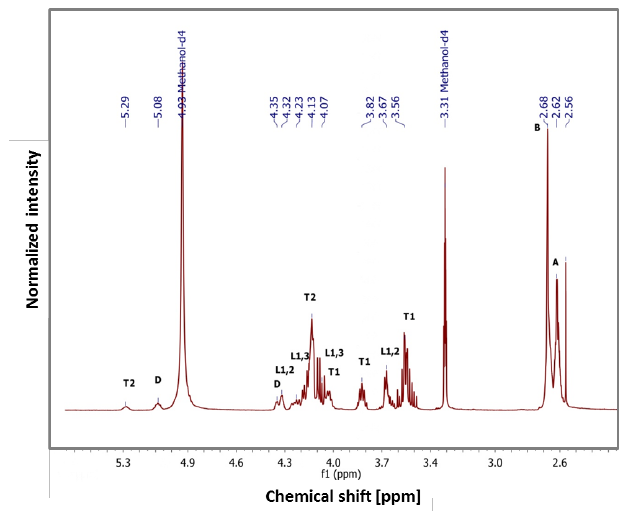
Figure 3. 1 H NMR spectra of PGSu (400 MHz, methanol-d 4 ) and signals characteristic for the PGSu structure: succinic end group (A), succinic ester (B), succinic acid (C), glycerol spin systems (D, T1, T2, L1.2, L1.3).